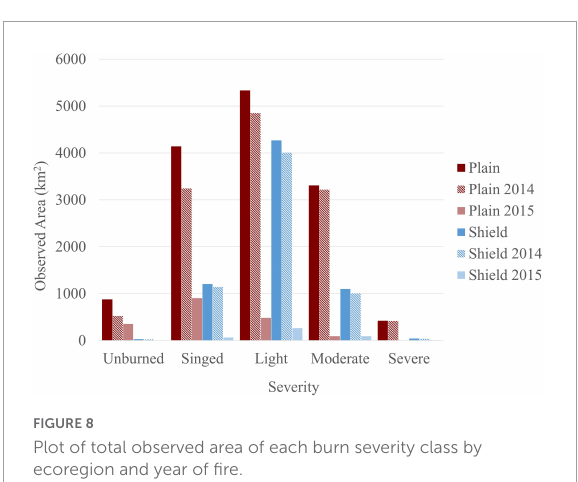
FIGURE8 Plot of total observed area of each burn severity class by ecoregion and year of